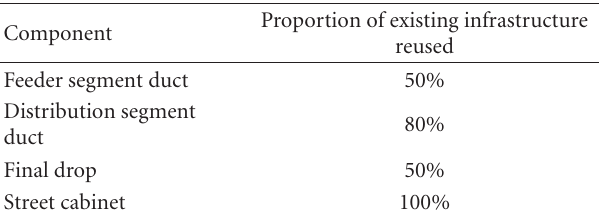
Table 1: General assumptions summary.